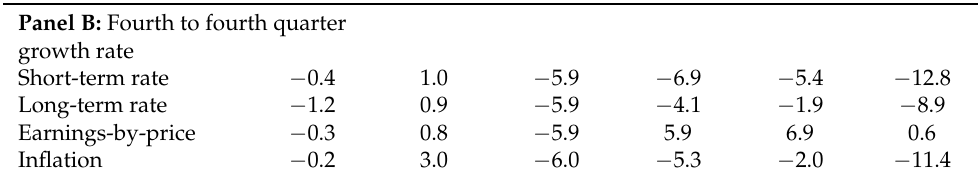
Table 4. Predictive power for the one-year excess stock returns Y